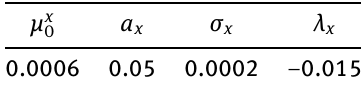
Table 3: Parameters of the force of mortality for the equity-longevity model and the complete model, chosen such that the ini- tial term structure of mortality T (cid:55)→ S x (0, T ) is similar to the corresponding curve under the legal Belgian MR-5 table. The market price of longevity risk has been chosen such that we are more conservative under the risk-neutral probability measure Q . µ x 0 a x σ x λ x